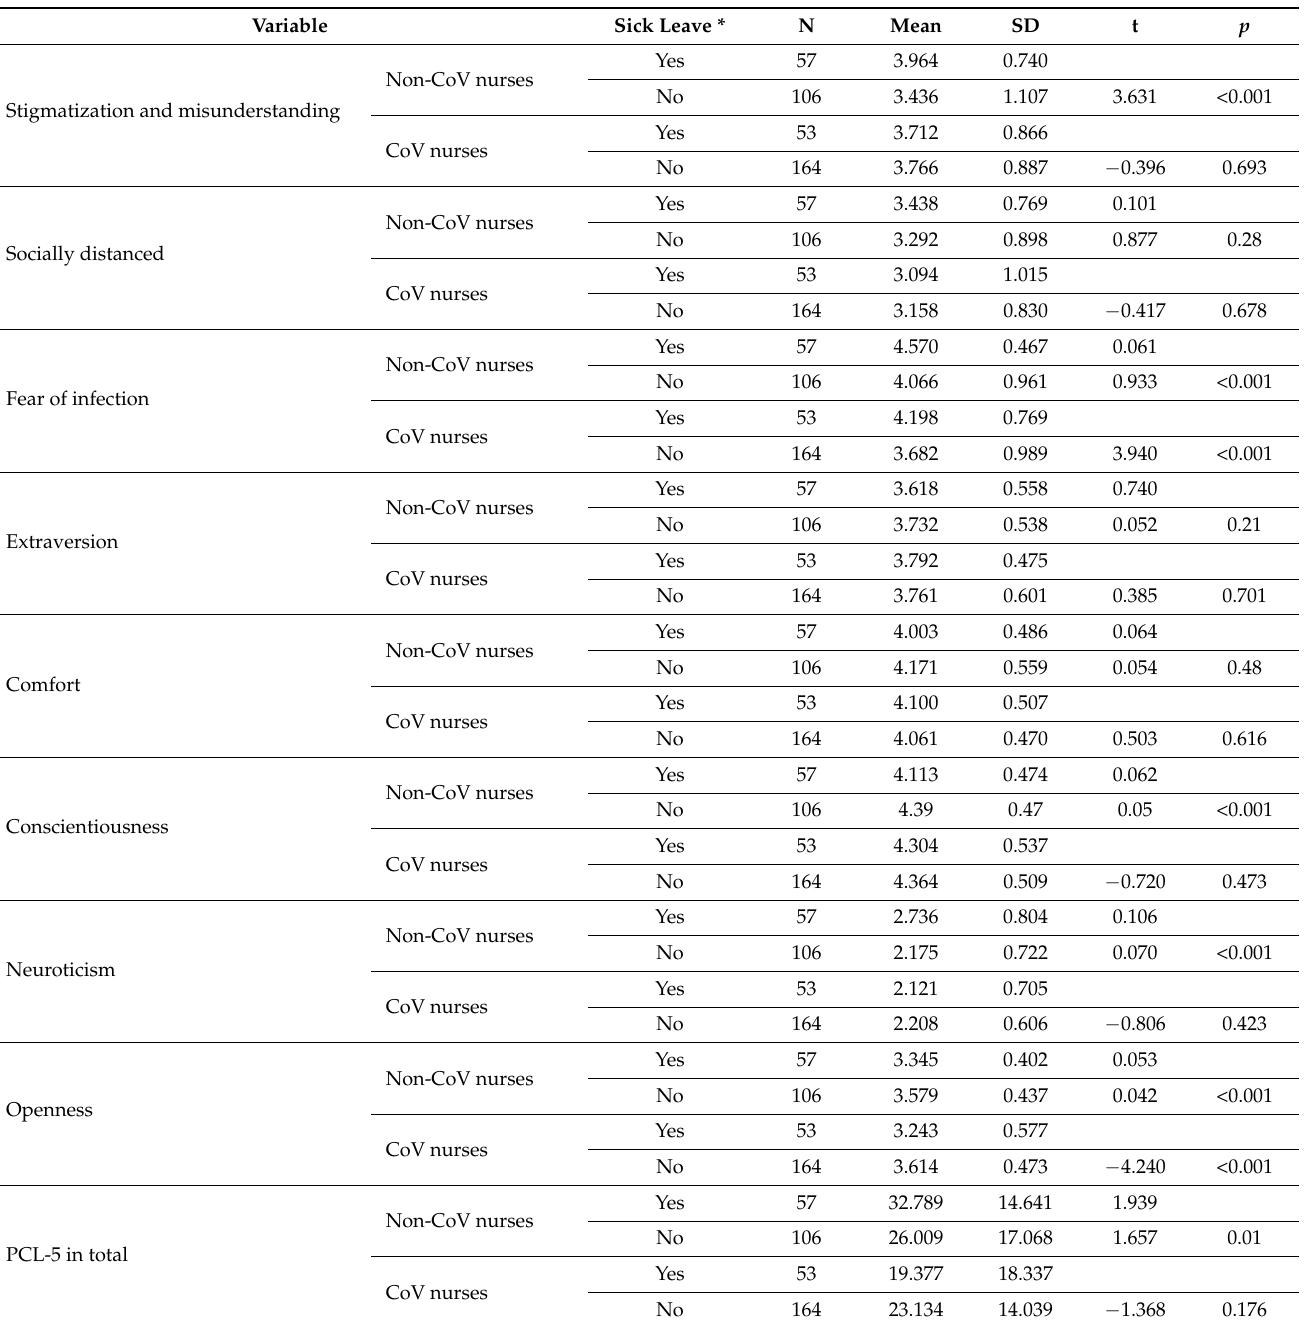
Table 3. Differences in pandemic experiences, psychological characteristics and psychological symp- toms regarding use of sick leave separately for nurses who worked and did not work in COVID-19